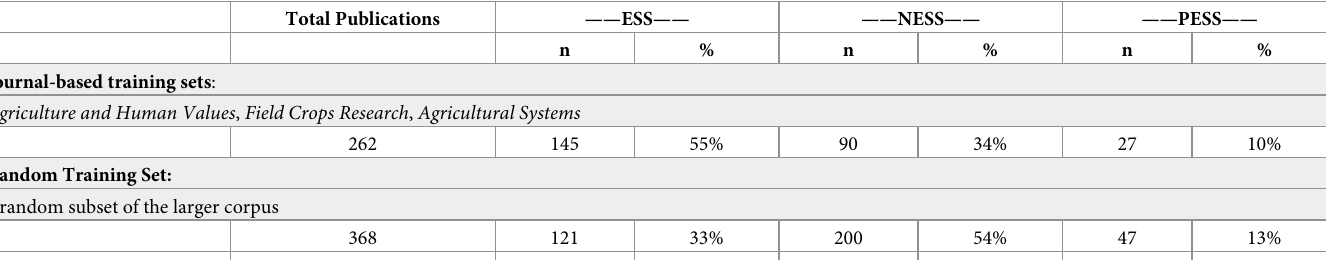
Table 3. The training